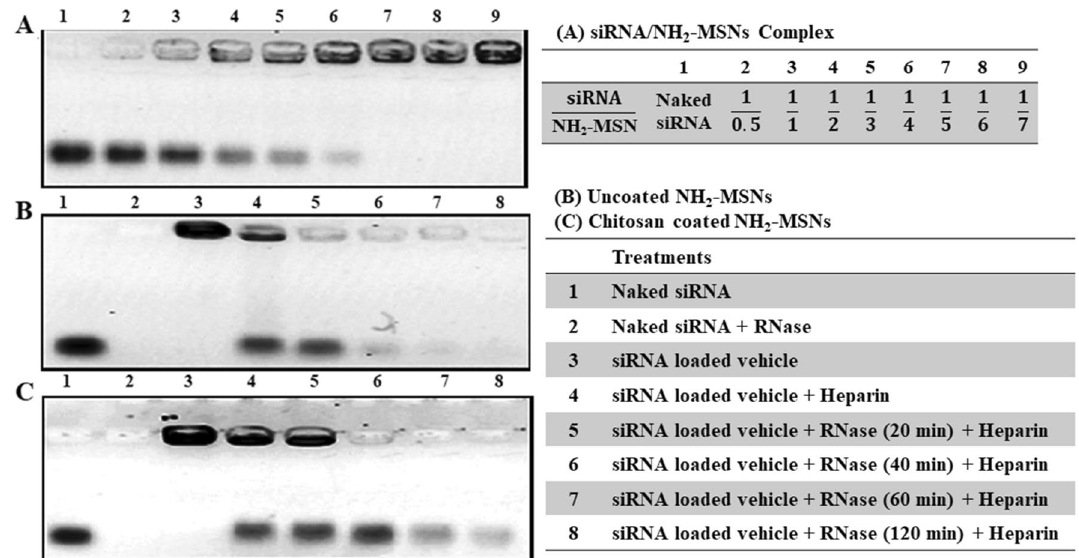
Figure 3. Electrophoretic mobility pattern of siRNA/MSN complexes from left to right: naked siRNA, 1:0.5, 1:1, 1:2, 1:3, 1:4, 1:5, 1:6, and 1:7 on agarose gel ( A ). RNase protection capacity for siRNA-loaded NH 2 -MSNs ( B ), and siRNA-loaded NH 2 -MSNs coated with chitosan ( C ). Wells from left to right: naked siRNA, naked siRNA treated with RNase, siRNA-loaded NH 2 -MSNs, heparin treated NH 2 -MSNs in the absence of the RNase, siRNA liberated from NH 2 -MSNs using heparin in the presence of the RNase for 20 min, for 40 min, for 60 min, and finally 120 min. Gel analysis revealed that MSNs coated with chitosan might provide greater protection for the loaded siRNA than MSNs not coated with chitosan. UVIDoc software version 12.4 was used to crop and color invert the images. The supplementary dataset contains original